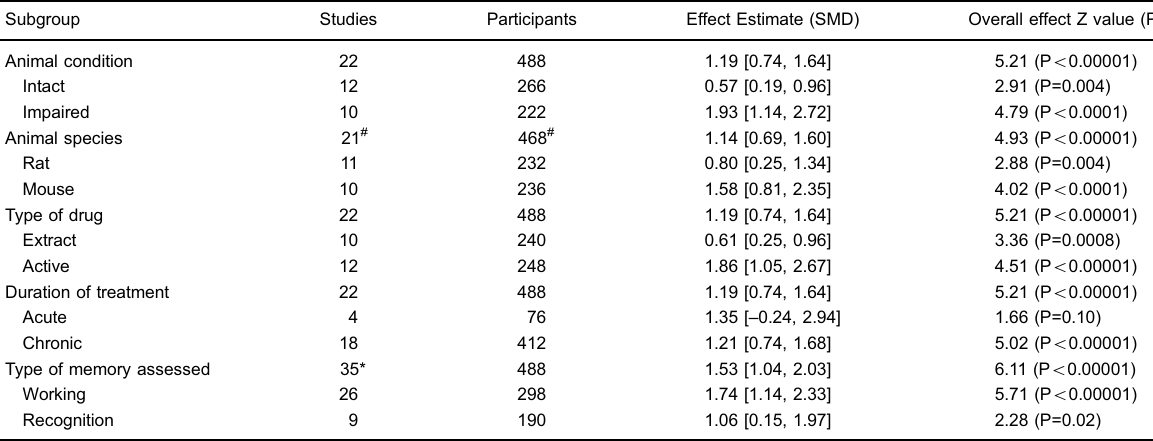
Table 1. Comparison of subgroup estimates (Hedges g, 95%CI) and overall effect.